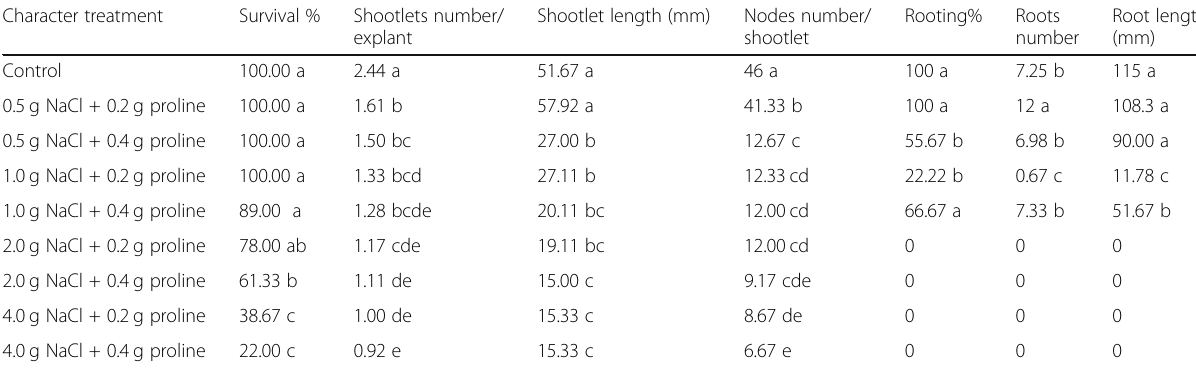
Table 3 Alleviation of salinity stress on the micropropagated Paulownia under the effect of proline concentration Character